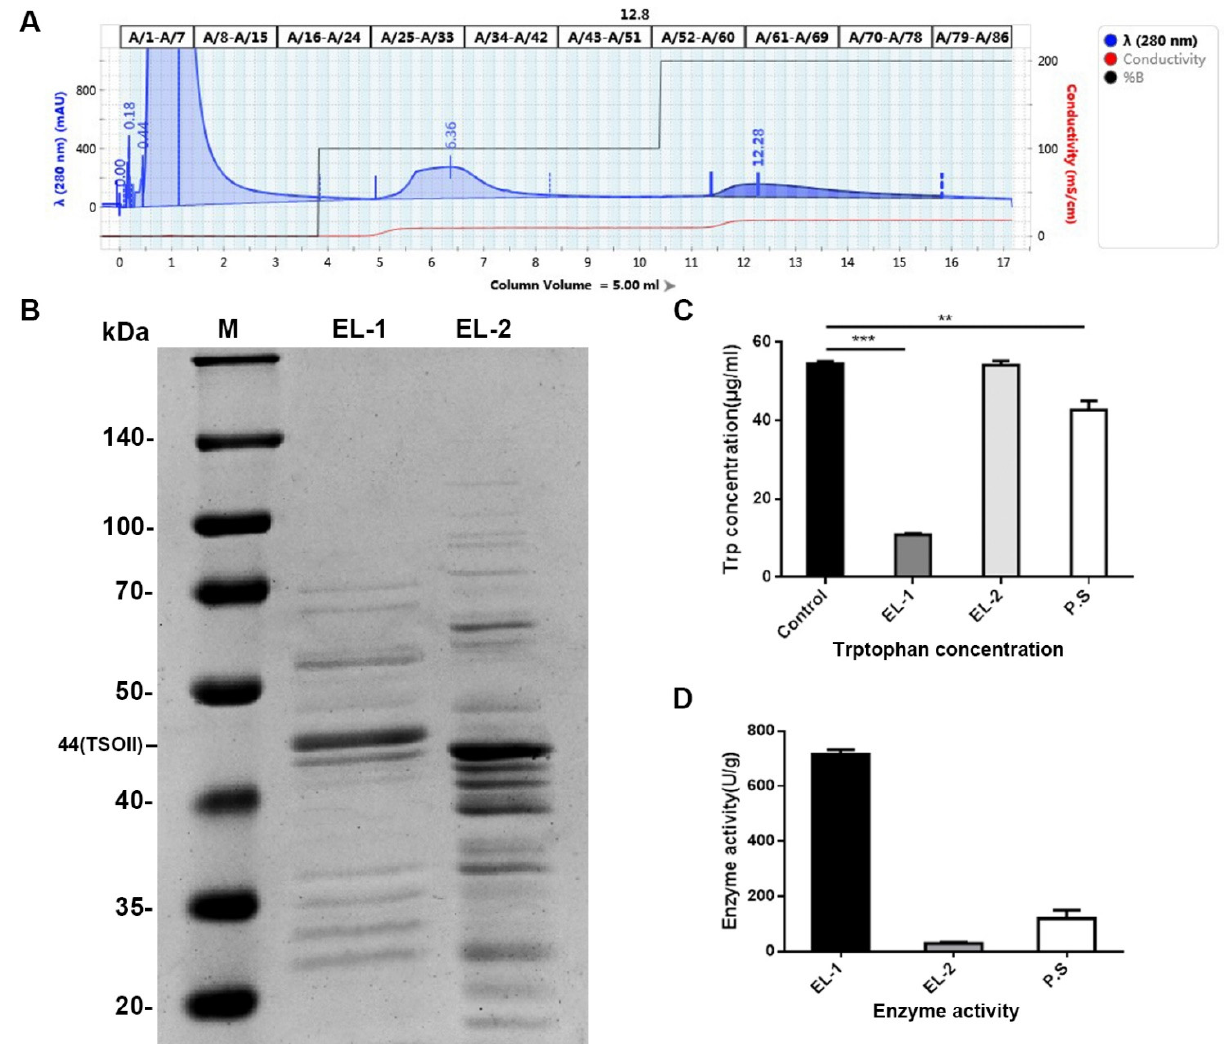
Figure 1. The purified TSO enzyme extracted from Pseudomonas degraded tryptophan. ( A ) Affinity chromatogram of TSO protein. The first peak is the flow-through peak, the second is the 0.05-M sodium acetate elution peak, the third is the 0.2-M sodium acetate elution peak. We collected 11.3–15.7 column volumes of eluent, which was the TSO protein we needed. ( B ) SDS diagrams of proteins in different eluents collected. EL-1 was a strip of 0.2-M eluent and EL-2 was a strip of 0.05-M eluent. In EL-1, the 44-kDa band of protein was TSOII. ( C ) Tryptophan concentration in enzyme activity assay. P.S was the total protein control group. EL-1 had the lowest tryptophan content, indicating the highest protein activity. Data are mean ± SD, n = 3; ** p < 0.01 and *** p < 0.001 vs. Control. ( D ) Enzyme activity of proteins collected from different eluents. The specific activity of EL-1 was significantly higher than that of